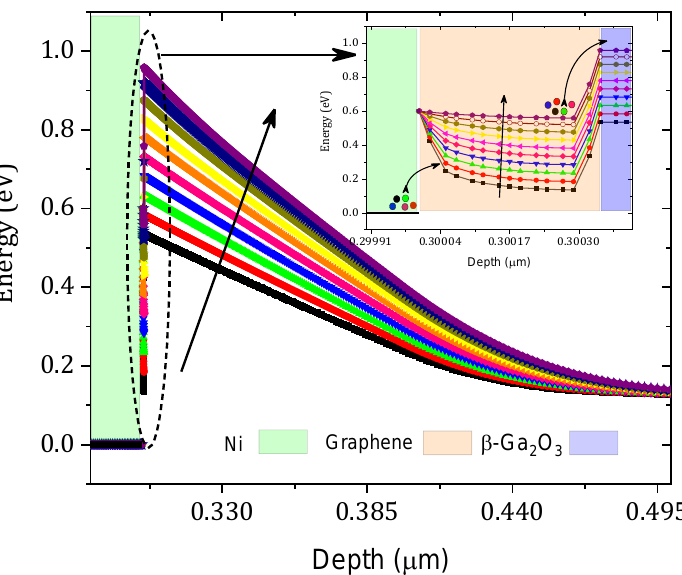
Figure 8. Equilibrium conduction band variation with the graphene workfunction. The inset is a zoomed Ni/graphene/ β -Ga 2 O 3 interface conduction band.